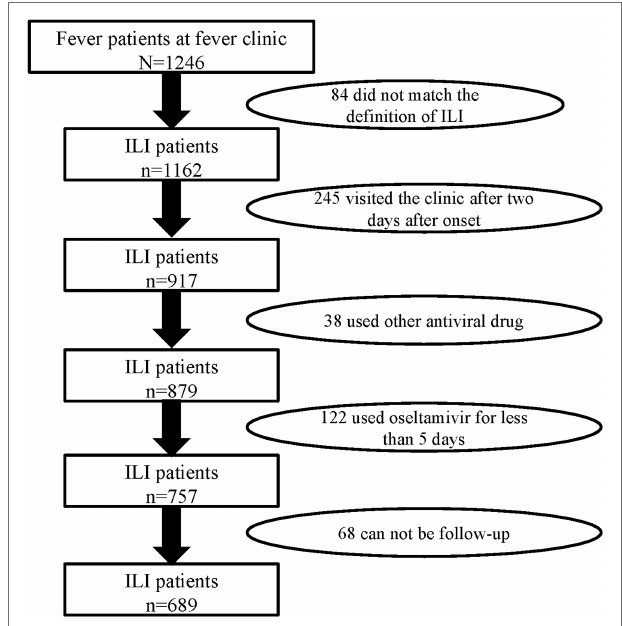
FIGURE 1 | Flowchart of reported patients in the study population and reasons for